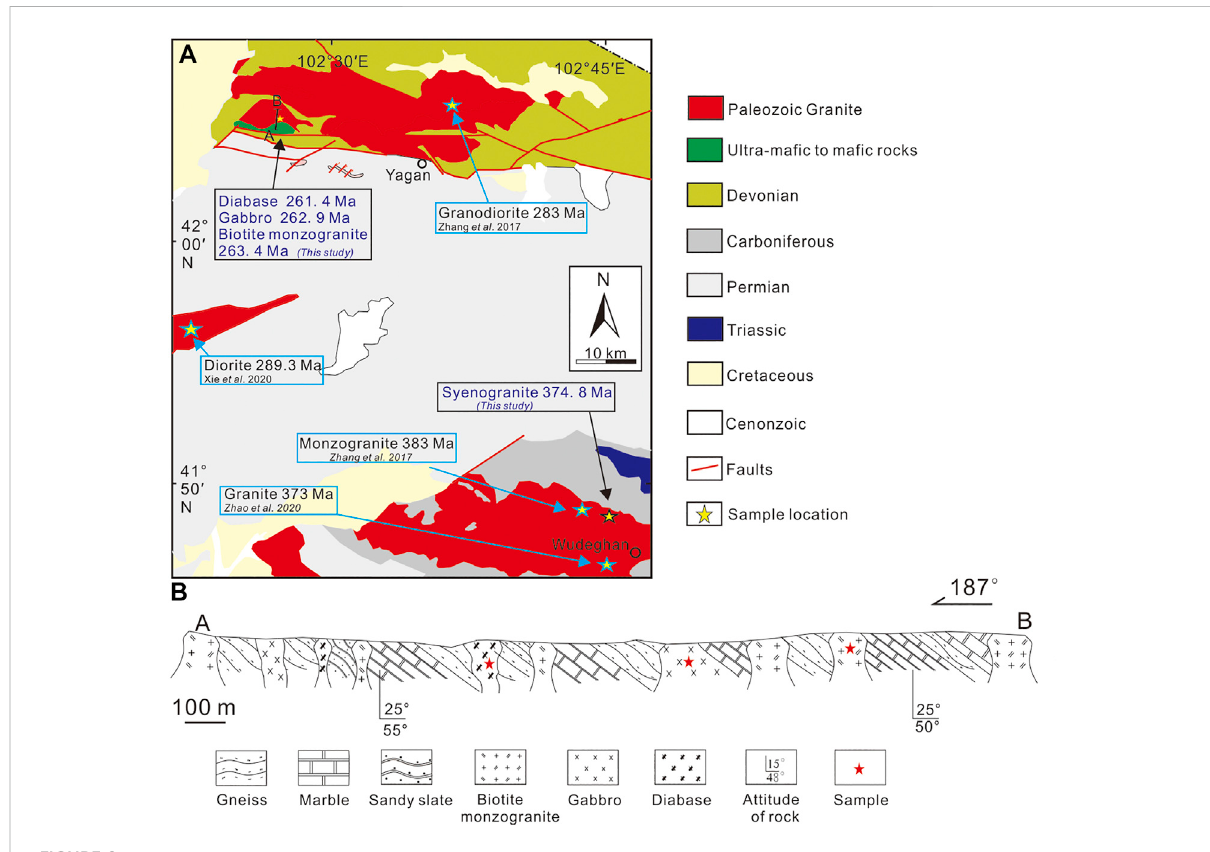
FIGURE 2 (A) Geological map of the studied area (Modi fi ed after 1:200,000 geological maps, Inner Mongolian Bureau of Geology and Mineral Resources, China); (B) Pro fi le of the Yagan bimodal intrusive